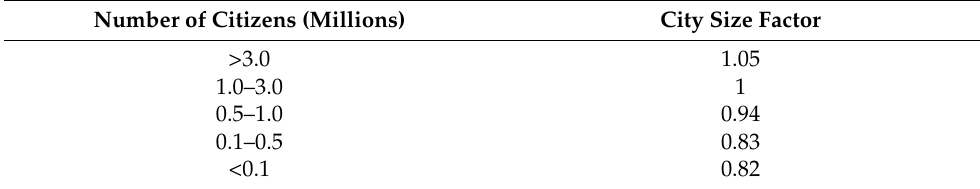
Table 2. City size factor for saturated flow